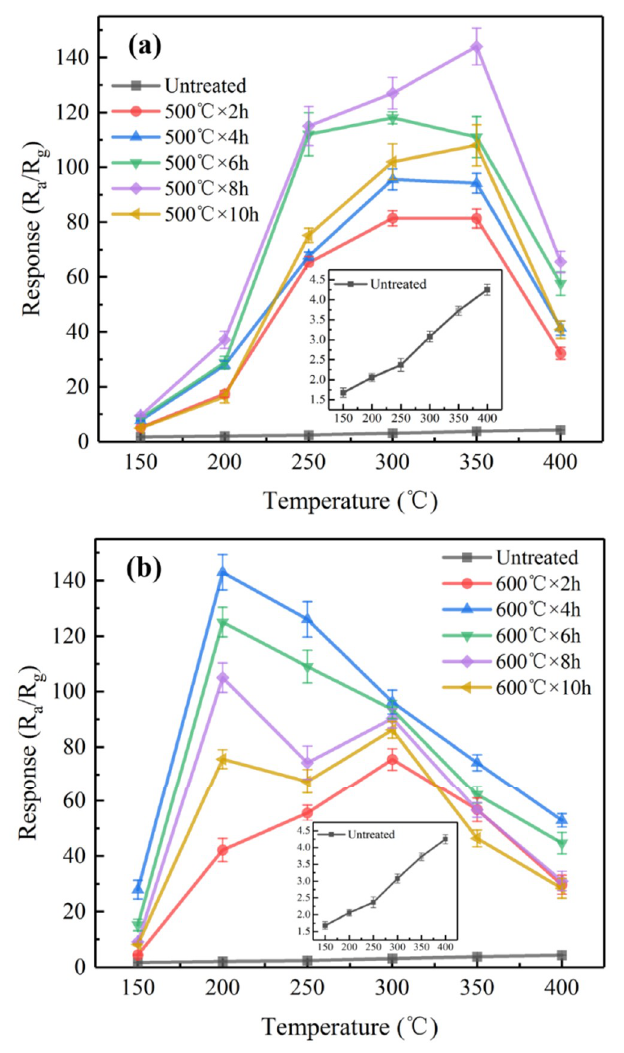
Figure 11. The responses of various sensors to 1000 ppm H 2 : ( a ) untreated and CVD treated at 500 ◦ C, ( b ) untreated and CVD treated at 600 ◦ C.